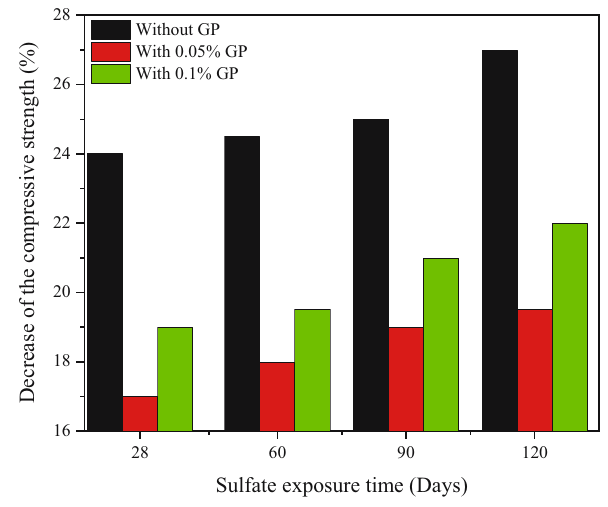
Figure 5: GP - modi fi ed mortar resistance to sulfate attack [ 58 ]